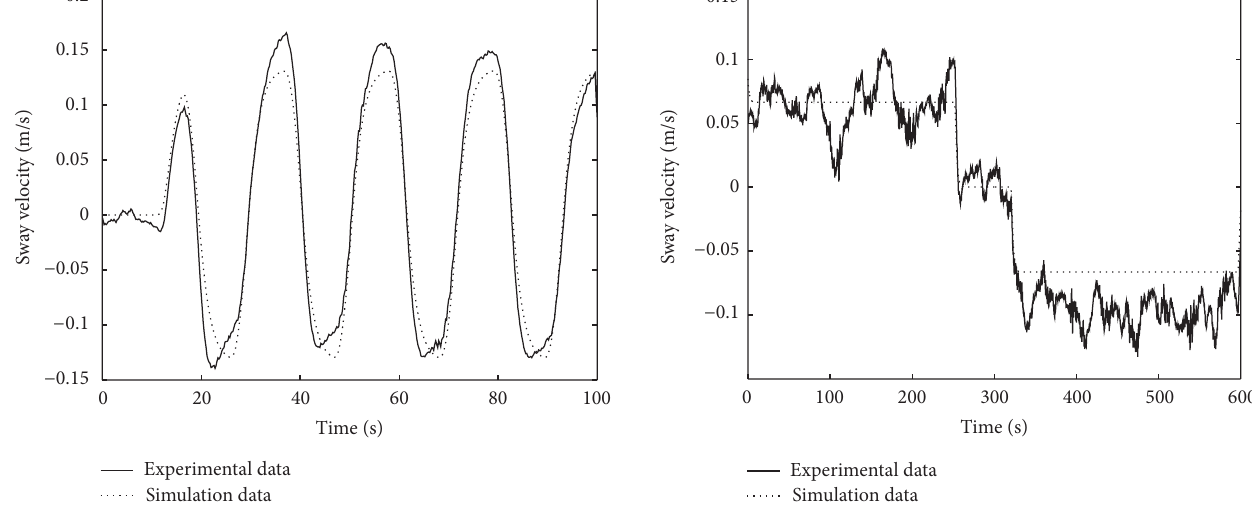
Figure5:Swayvelocitymeasuredinthezig-zagmanoeuvrewiththe ship (solid line) and in simulation (dotted line).